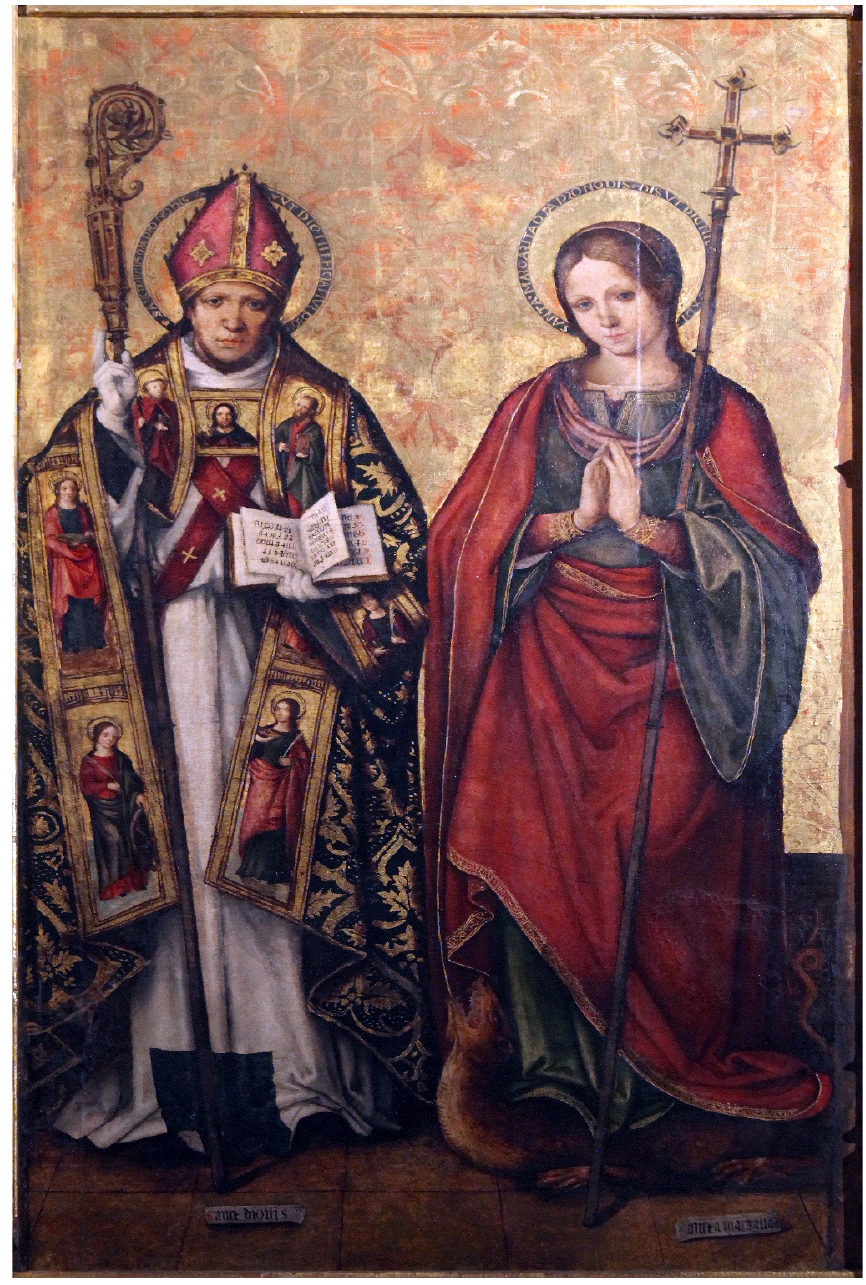
Figure 1. Saint Dionysius and Saint Margaret.